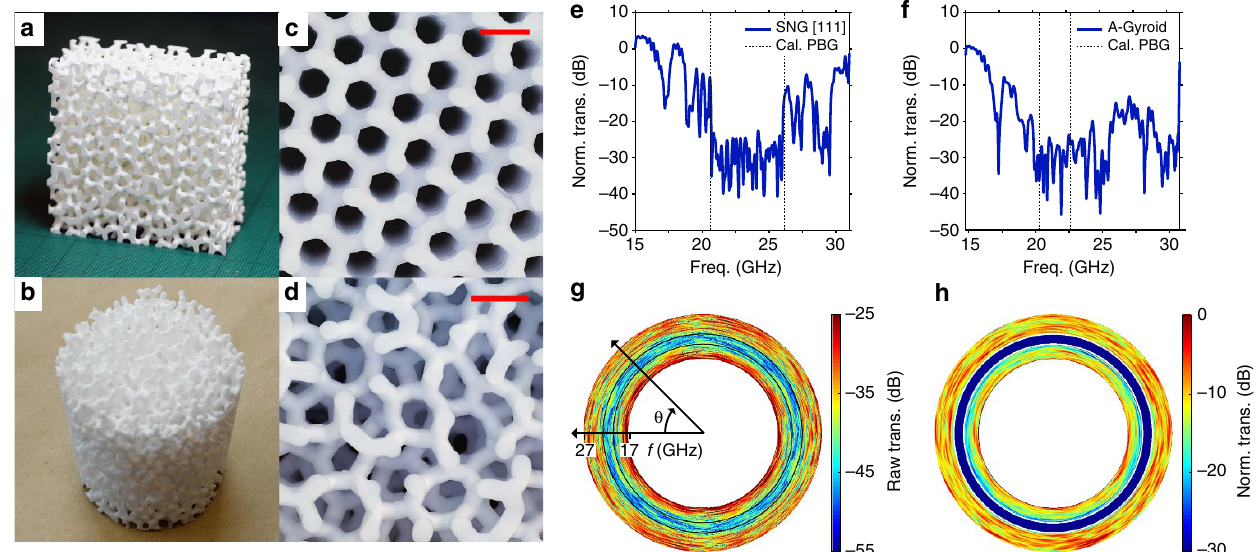
Figure 5 | Microwave experiments with single network and amorphous gyroid structures. Alumina prototypes of amorphous gyroid, both a single piece cuboid ( a ) and a compound cylinder ( b ). View down the (111) axis of our single-network gyroid sample ( c ), and along an arbitrary axis of amorphous gyroid ( d ), showing the network quality. Comparison of transmission between single-network gyroid (SNG [111]) and amorphous gyroid (A-Gyroid) cuboidal samples ( e , f , respectively), with gap edges predicted by plane wave expansion (vertical dashed lines); measured data was smoothed by Fourier filtering for clarity. Measured ( g ) and simulated ( h ) polar false-colour maps of transmission for the amorphous gyroid cylinder, with gap edges calculated by band structure overlaid as black and white rings, respectively. Scale bars in ( c , d )